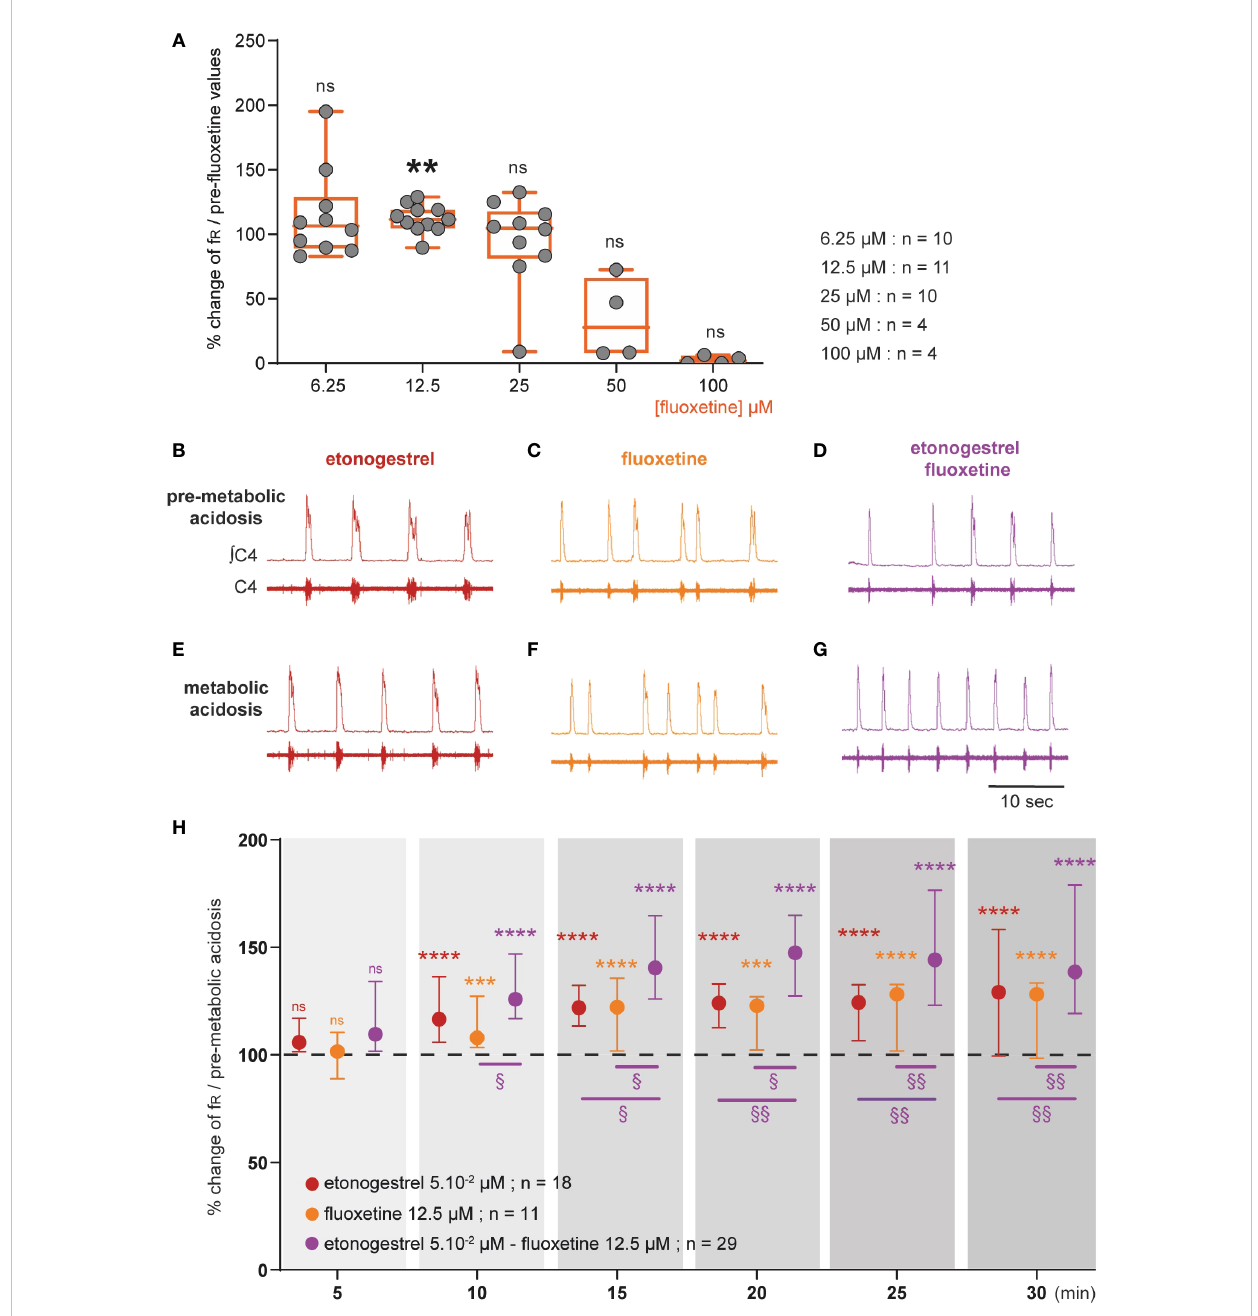
FIGURE 6 Effect of an increase in 5-HT signaling by fl uoxetine on the respiratory response to metabolic acidosis under exposure to etonogestrel in OF1 mice. (A) , Scatter plots with a superimposed box and whisker plot (median [Q1; Q3]) showing percentage of change offR under 6.25 (n=10), 12.5 (n=11), 25 (n=10), 50 (n=4) and 100 µM (n=4) of fl uoxetine. **p < 0.01 indicates a signi fi cant change in fR relative to pre- fl uoxetine values (paired t-test or Wilcoxon matched pairs signed rank test depending on the normality of data distribution). (B – G) , Individual phrenic activity traces (fourth cervical ventral nerve root, C4) and integrated C4 activity from medullary-spinal cord from OF1 mice in normal-pH ( B – D ; pre-metabolic acidosis) and metabolic acidosis (E – G) conditions, under etonogestrel (B, E) , fl uoxetine (C, F) , or etonogestrel/ fl uoxetine (D, G) exposure. (H) , Median with interquartile range [Q1; Q3] illustrating the respiratory-like rhythm (respiratory frequency, fR) during the metabolic acidosis challenge per 5-min window under etonogestrel (red circles, n=18), fl uoxetine (orange circles, n=11), and etonogestrel/ fl uoxetine (purple circles, n=29) exposure. Under etonogestrel/ fl